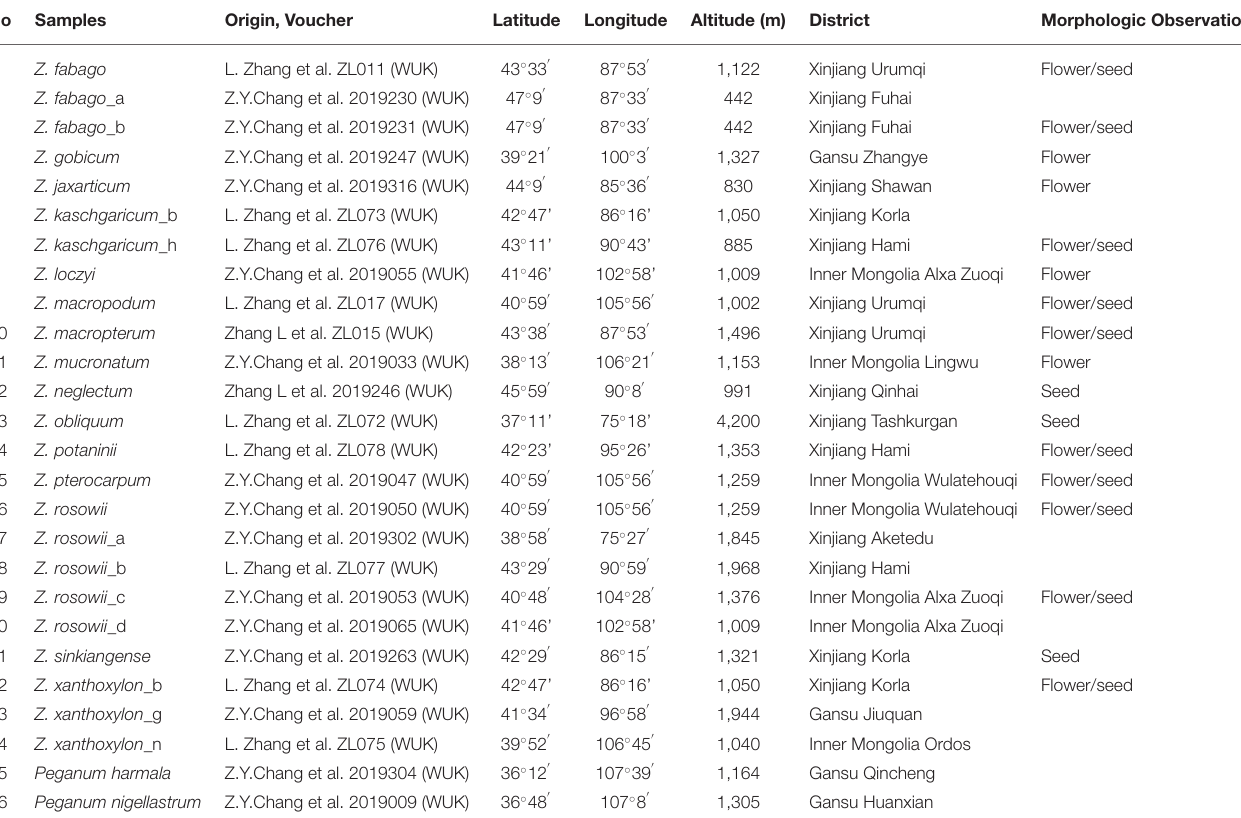
TABLE 1 | Details of sampled accessions used in this